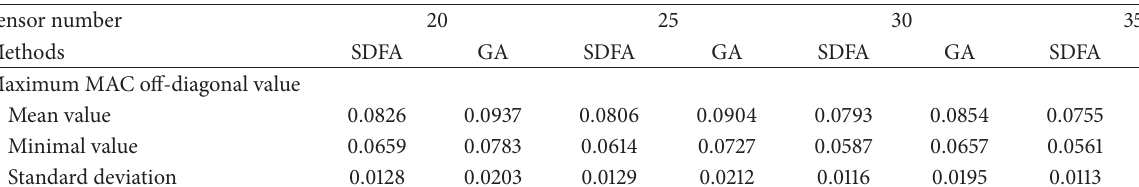
Table 4: Comparison of optimization results based on the MAC.